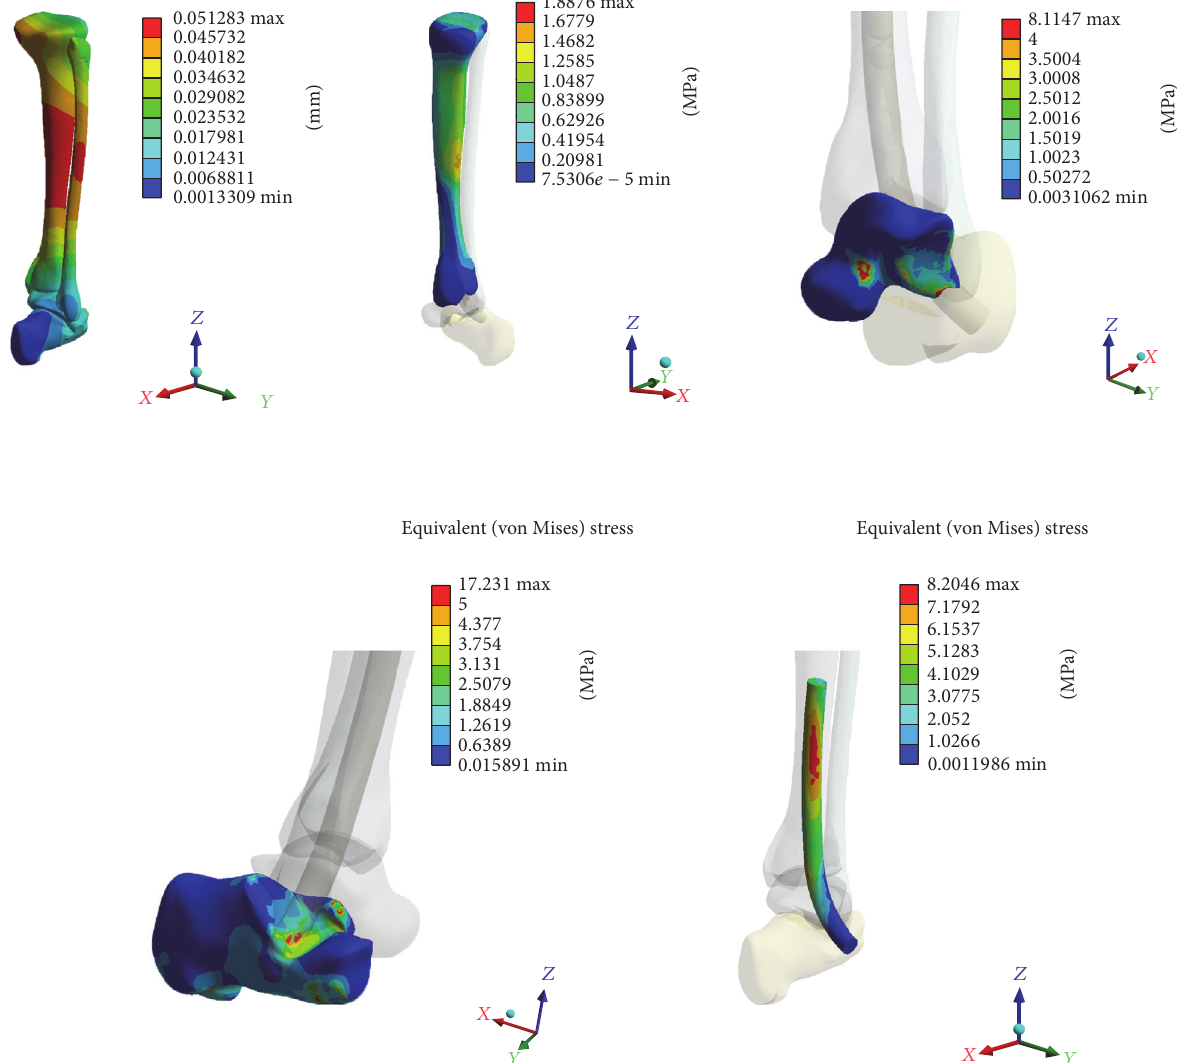
Figure 3: Computational stress analysis with high stress areas at the mid tiba and fibula, at the insertion point of the talus, and in the calcaneus at the area closest to the nail curvature. The nail itself sees the most stress in the proximal